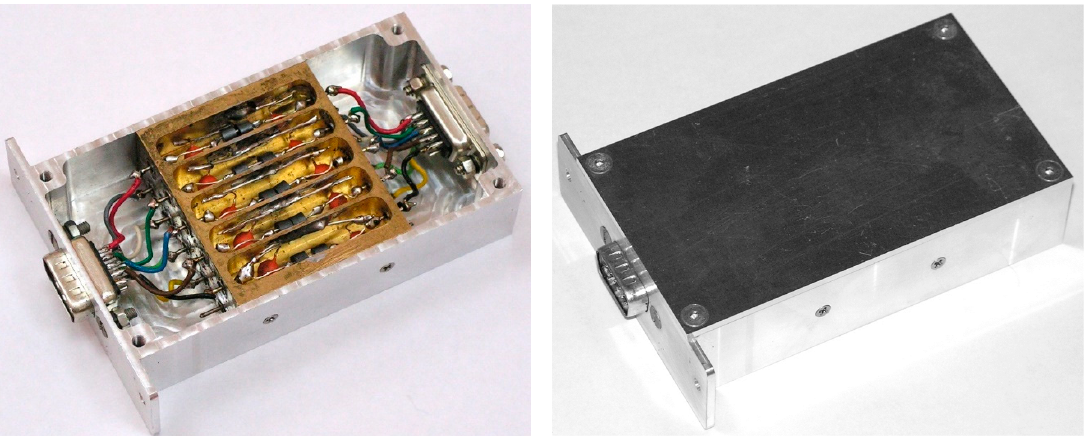
Figure 2. Filtration forming module.